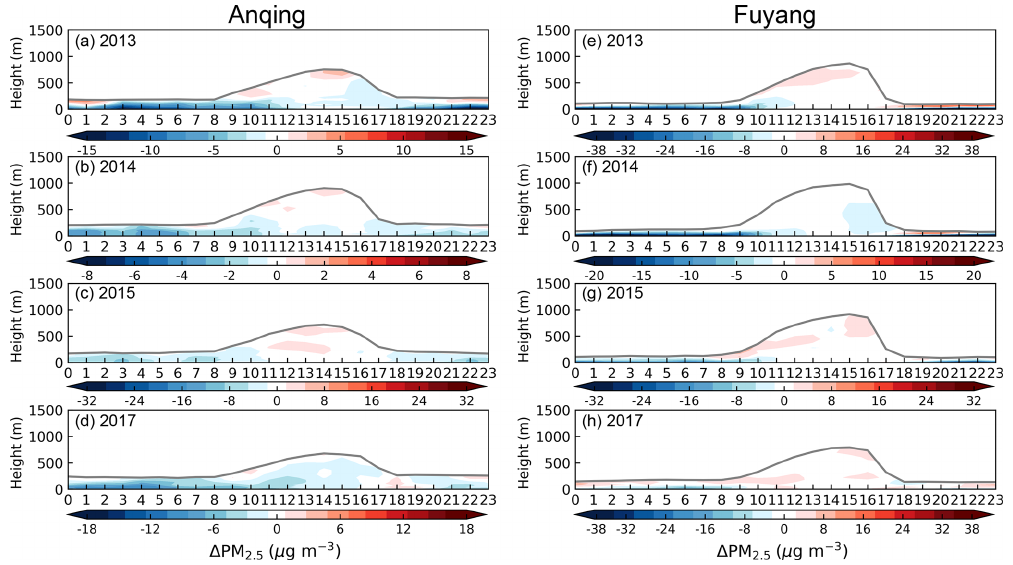
Figure 6. Time–height cross sections for the difference of PM 2 . 5 concentration between original and new schemes (i.e., the new scheme minus the original scheme) within the PBL in (a–d) Anqing and (e–h) Fuyang from 2013 to 2017. The gray line indicates the PBLH.